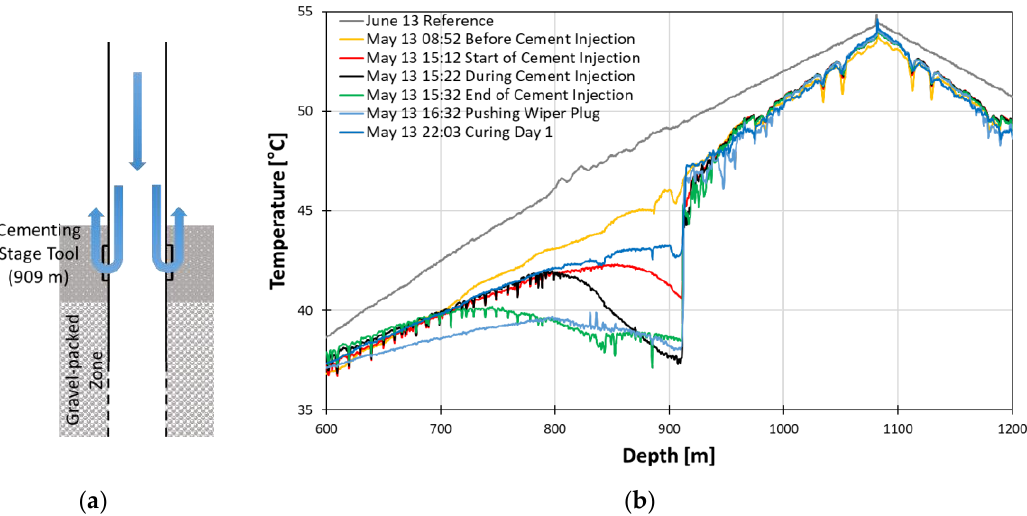
Figure 17. Schematics of cementing injection process ( a ) and temperature profiles during the cement injection process ( b ).